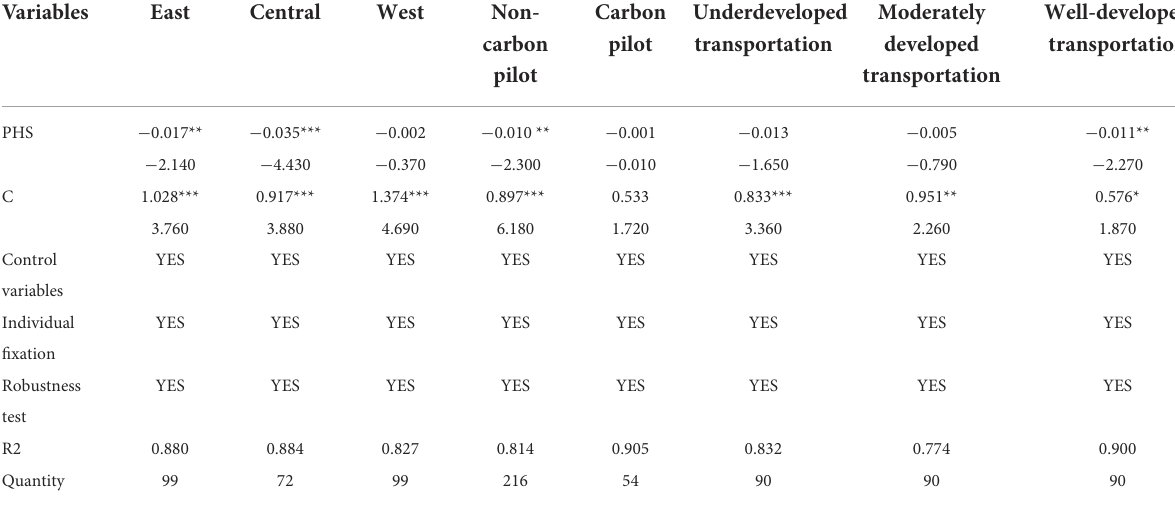
TABLE 9 Heterogeneity of geographic location, carbon trading pilot, and traffic